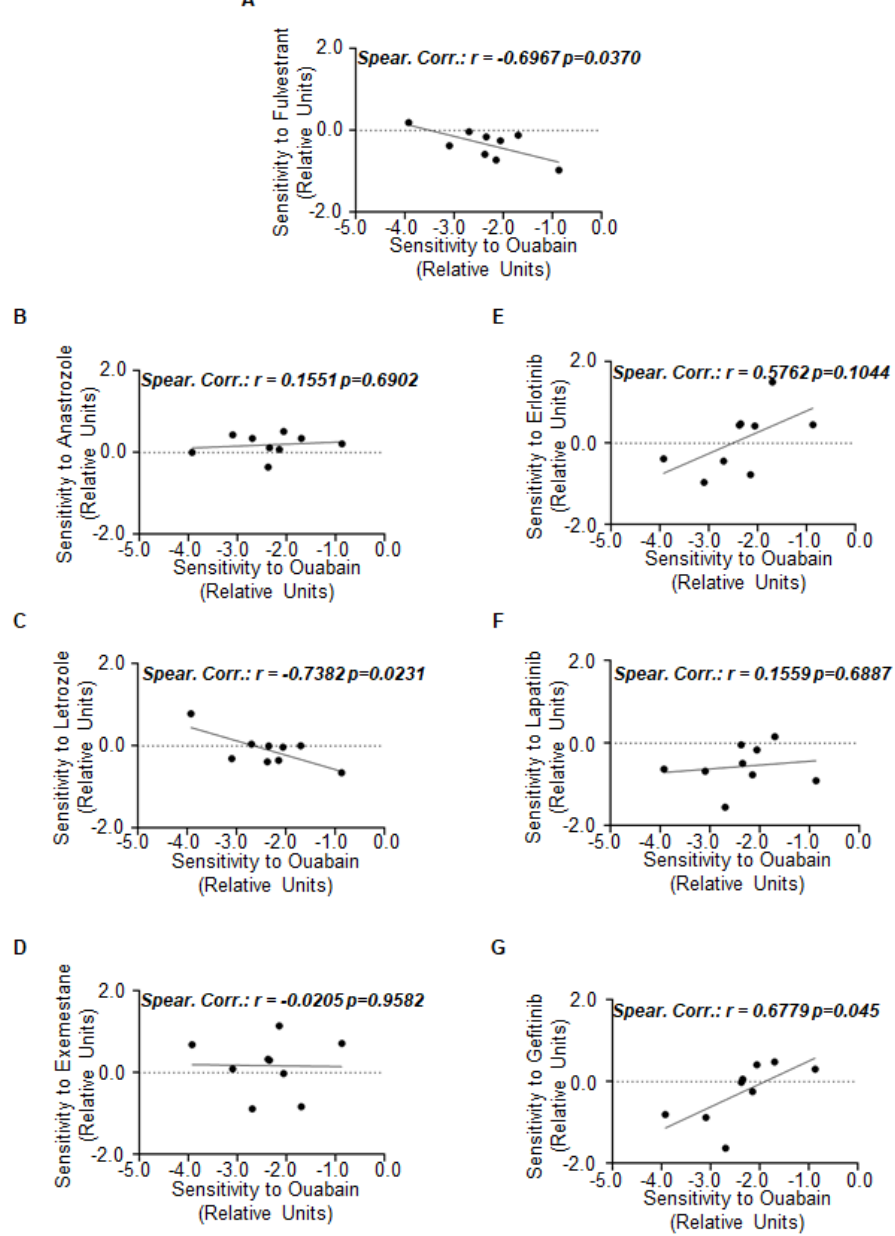
Figure 6. The correlation between the sensitivity to ouabain and the drugs used for breast cancer treatment in breast cancer cell lines. Plots have been generated by using the data in the DepMap portal. Each dot of the plots refers to the value of the specific parameter in a single ER α -positive breast cancer cell line. For details, please see Supplementary Table S6. ( A – G ) Linear regression between sensitivity to ouabain (OU) and the indicated drugs.